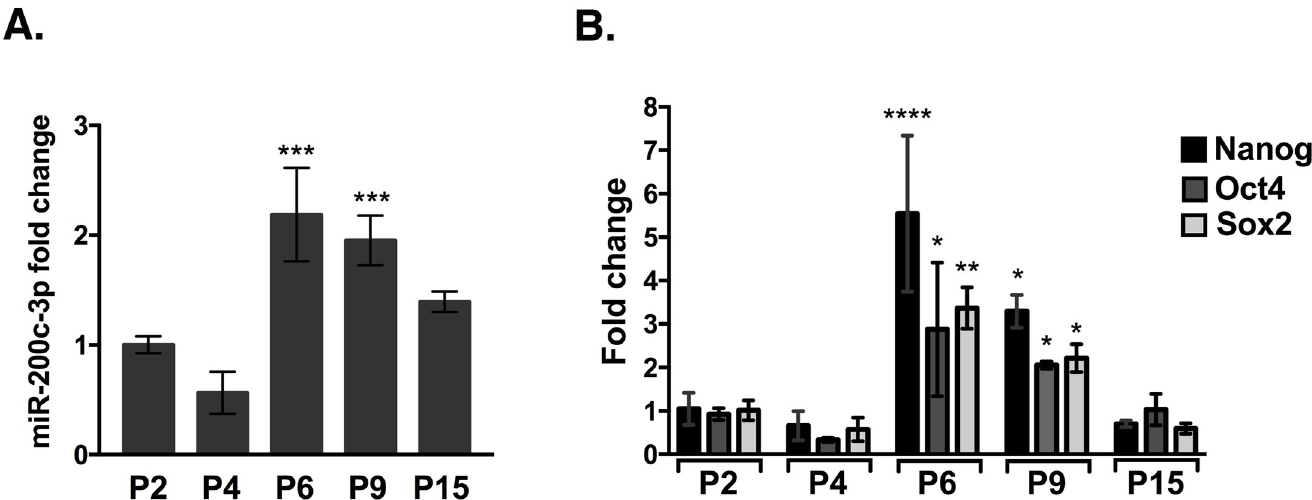
Fig 1. MiR-200c-3p and stemness markers expression during in vitro passages in ASCs. A. MiR-200c-3p expression by qRT-PCR, during in vitro passages (P). MiR-200c-3p expression was normalized to U6. SD ± are the mean of three independent experiments. Dunnett’s multiple comparisons test was applied to compare P2 with each of the passages. � p < 0.05, �� p < 0.01, ��� p < 0.001. B. Stemness markers during the in vitro passages were normalized to GAPDH. SD ± are the mean of three independent experiments. Ordinary one-way Anova, Dunnett’s multiple comparisons test was performed for each stemness marker and p values were calculated comparing P2 with the rest of the passages. � p < 0.05, �� p < 0.01, ���� p < 0.0001.